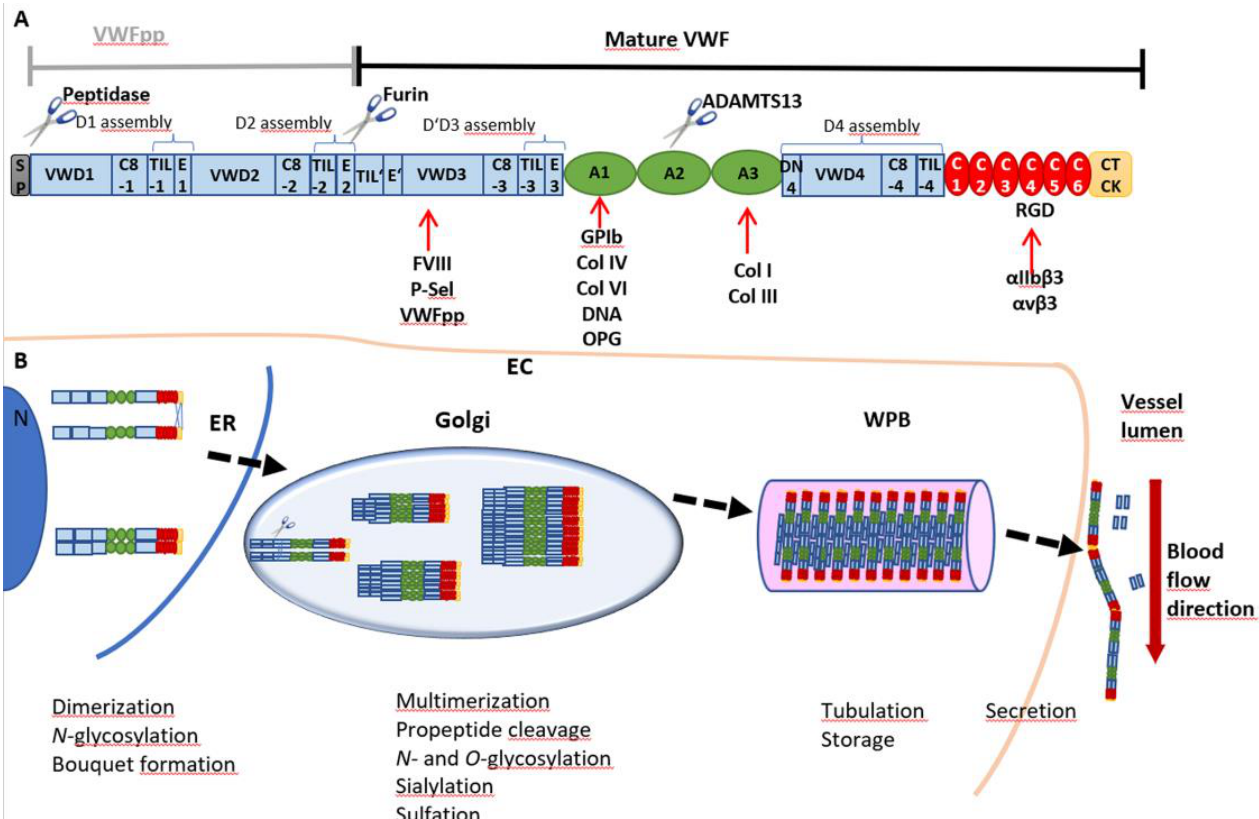
Figure 1. VWF domain structure and multimer biosynthesis. ( A ) VWF is synthesized as a pre-pro-monomer with a signal peptide (SP) and a pro-peptide (VWFpp) containing the D1 and D2 assemblies, each consisting of a VWD, C8, TIL and E domain. The VWFpp is cleaved off by furin, leaving the mature VWF, including the D’D3 assembly and domains A1, A2 and A3, followed by the D4 assembly, C1-C6 and the CTCK domains. Cleavage and thus degradation of VWF can occur between Tyr1605 and Met1606 of the A2 domain by a disintegrin and metalloproteinase with a thrombospondin type 1 motif, member 13 (ADAMTS13). Binding partners are indicated below the respective domains: coagulation factor VIII (FVIII), P-selectin (P-sel) and the VWFpp interact with D’D3; the A1 domain is the binding site for glycoprotein Ib α (GPIb α ), collagens (Col) IV and VI, DNA and osteoprotegerin (OPG); collagens I and III bind to A3; and the RGD motif in C4 is the interaction site for integrins αIIbβ3 (= receptor GPIIb/IIIa) and αvβ3. ( B ) The SP guides translation into the endoplasmic reticulum (ER), where monomers are dimerized by the formation of three disulfide bonds between the CTCK domains. Further N -glycosylation is initiated, and dimers arrange into a “bouquet-like” formation with a closed stem region. In